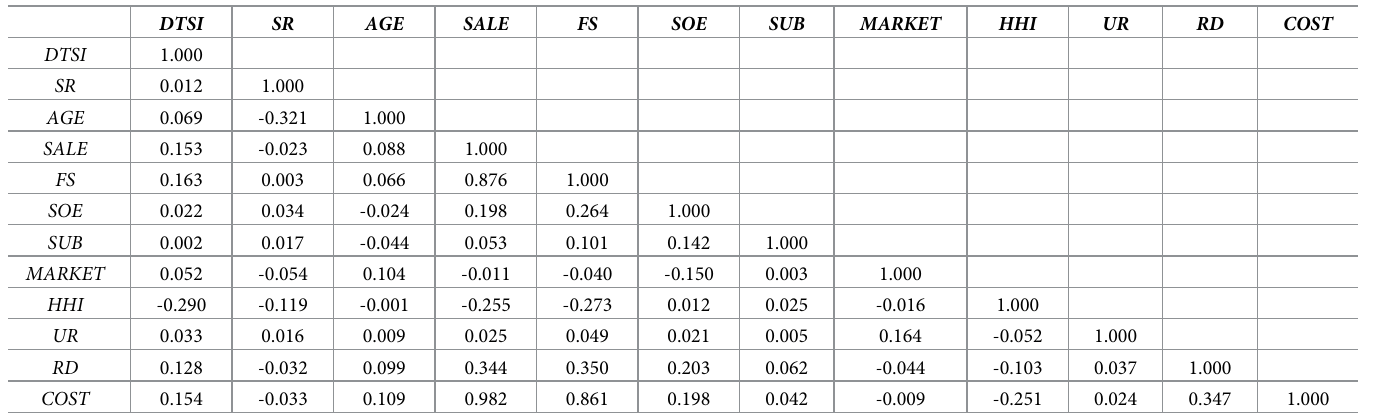
Table 2. Correlation